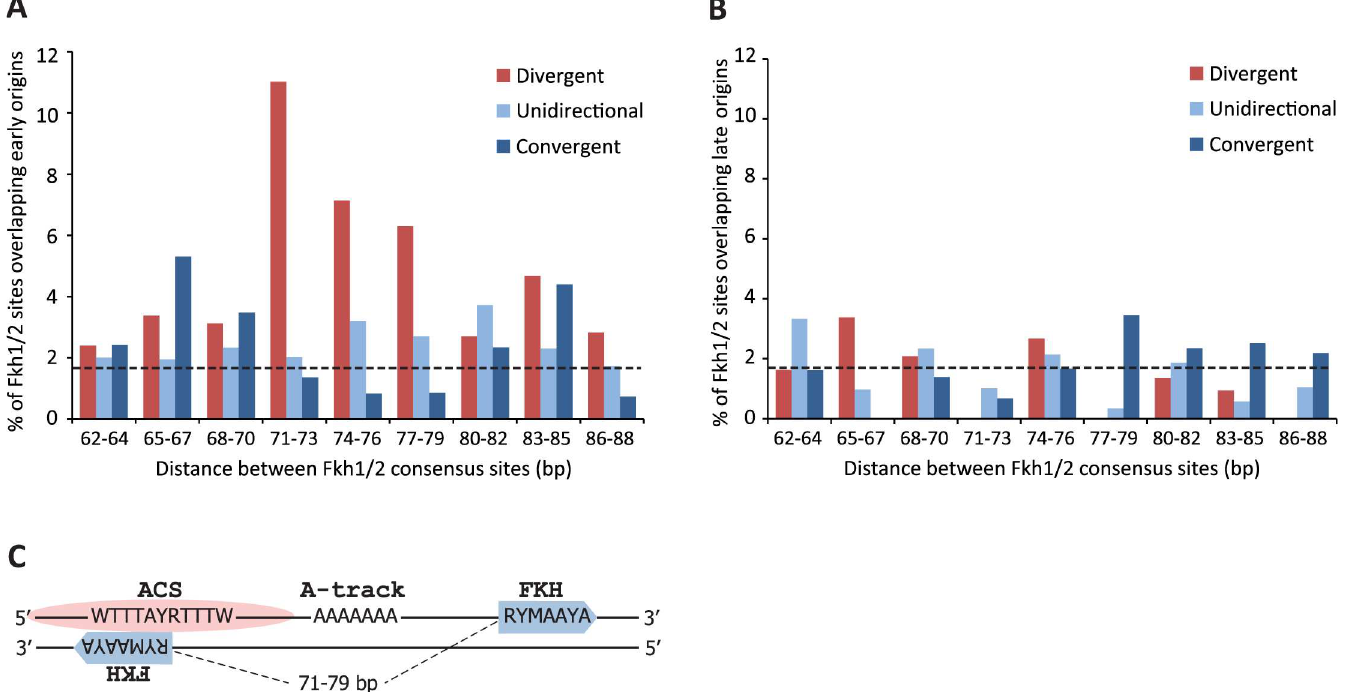
Fig 3. Analysis of Fkh1/2 binding sites at replication origins. (A) Double Fkh1/2 bindingsites (RYMAAYA) with different spacingand orientation were located throughout the yeast genome.The sites were then mapped onto a genome-wide early DNA replicationinitiationprofile [8]. Percentageof double Fkh1/2 sites that co-localizewith early-replicating loci is shown. Black dashedline indicatesthe backgroundand is calculatedas averagefrequency of overlap betweenscrambledFkh1/2 doubleconsensussites (in all orientations; with 50–100bp gap) and early origins. (B) Distributionof doubleFkh1/2 sites at late replicationoriginswas analysedas in A . (C) The generalpattern of sequenceelementsin early replication origins with divergentFkh1/2 bindingsites. Two Fkh1/2 sites (blue arrows) are separated by a stretch of 71–79bp linker DNA that containsa poly-A track. Locationof the ACS (pink ellipse)varies, but is typically found in close proximity to or overlapping with one Fkh1/2 site. The ACS-proximal Fkh1/2 consensussequenceis located on the DNA strand complementary to that containing the ACS. The model is based on alignment of 20 early origins containing divergentFkh1/2 bindingsites (see text and S3 Fig for